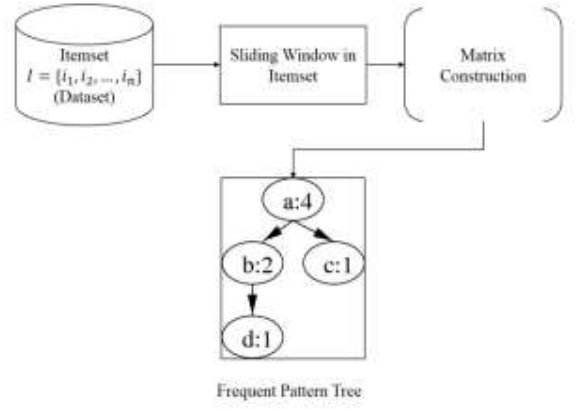
Figure 1. The architecture of the proposed MFPT method in pattern